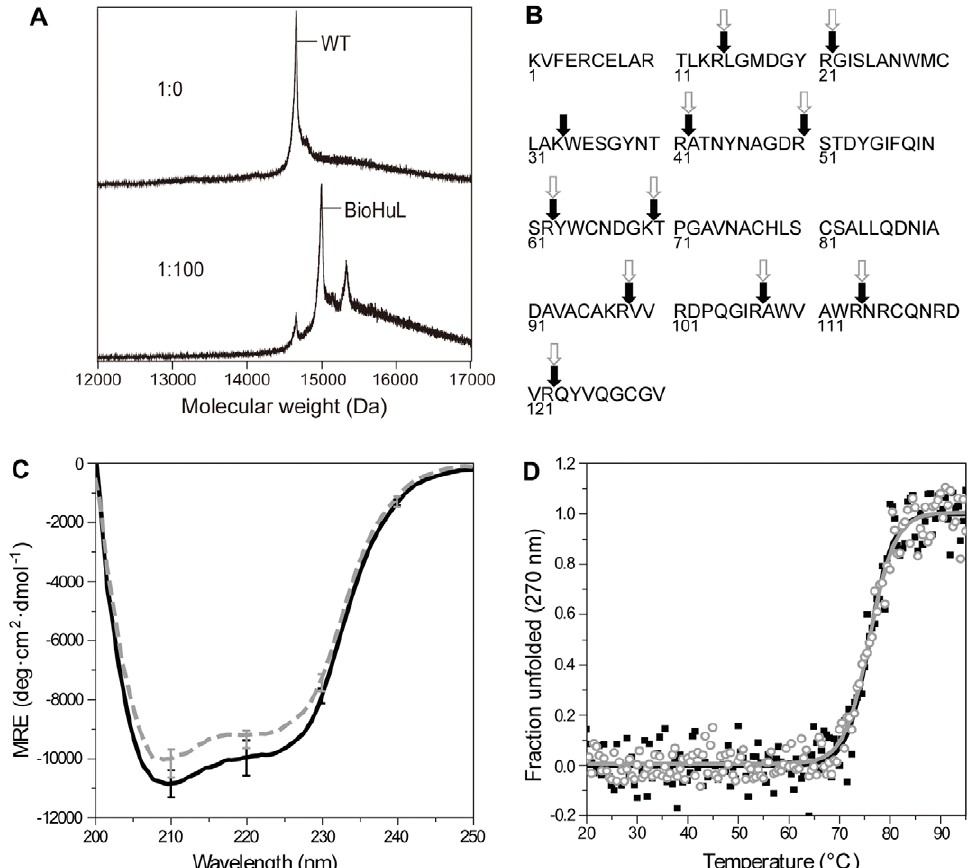
Figure 1. Effects of biotinylation on lysozyme. (A) MALDI mass spectrometry of lysozyme incubated in the absence (upper) and the presence (lower) of 100-fold molar concentration of BioNSE. (B) Primary sequence of human lysozyme showing the sites where trypsin digestion has occurred in BioHuL (open grey arrows) and WTHuL (filled black arrows). (C) Secondary structure of BioHuL (dashed grey line) and WTHuL (solid black line) by far-UV CD. (D) Thermal denaturation curves of BioHuL (open grey circles) and WTHuL (filled black squares) monitored by near-UV CD. Mid-point T m values are defined as the temperatures at which 50% of the population of protein molecules is unfolded.